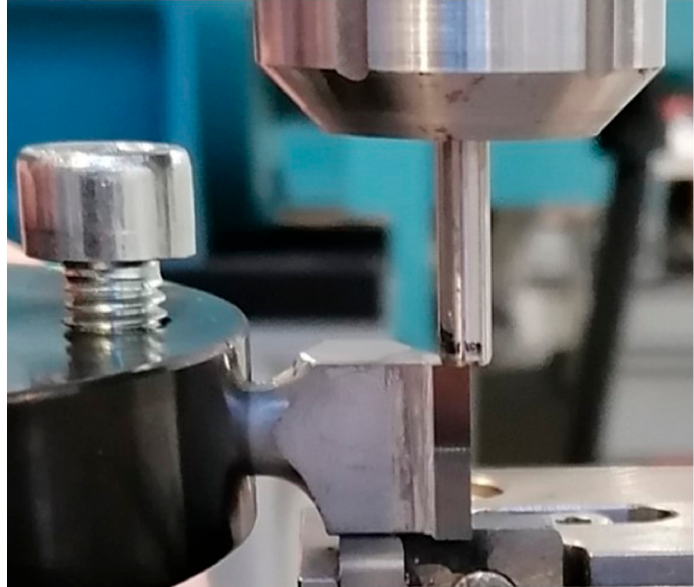
Figure 5. Specimen shear testing setup.